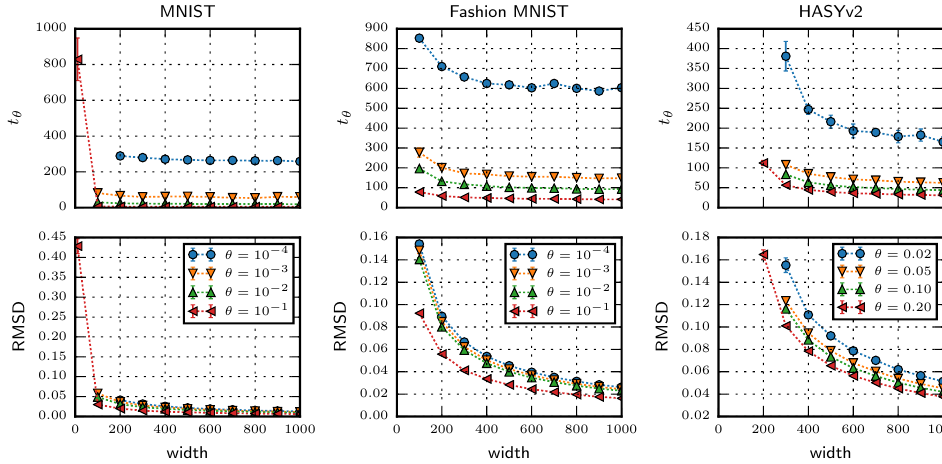
Figure 6. Top: Time t θ (in epochs) at which the networks first reach a given value θ . Bottom: Root mean square deviation (RMSD) between the initial configuration of weights of a network and its configuration of weights at time t θ . From left to right: networks trained on the MNIST, Fashion MNIST, and HASYv2 datasets. Each point in the figure is the average of five independent test runs. The absence of a point in a plot indicates that the network does not reach this loss during the entire period of